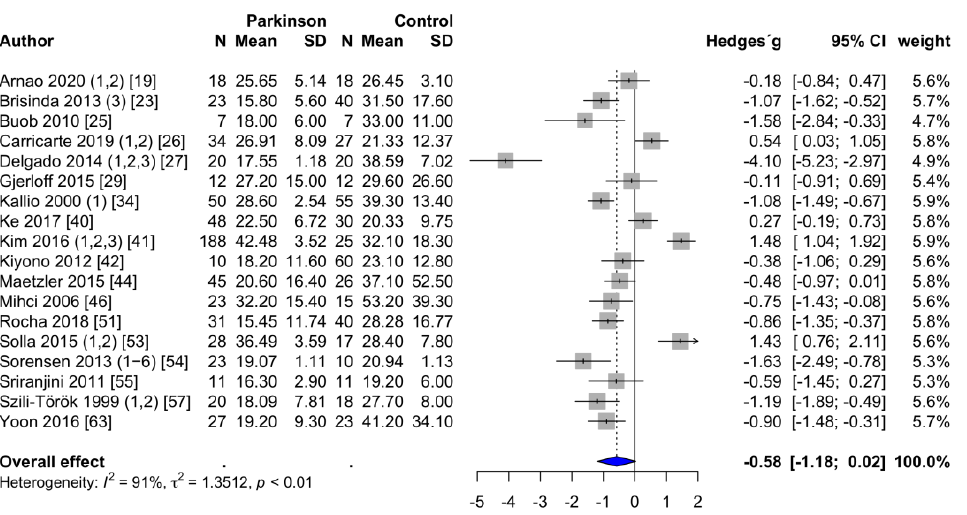
Figure 4. Forest plot RMSSD, random-effects meta-analysis. RMSSD: Root mean square of successive normal-to-normal interval differences.